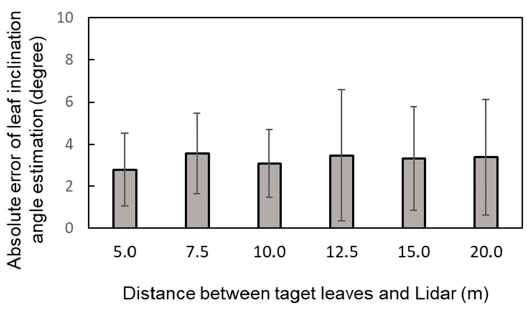
Figure 4. Relationship between distance to target leaves from lidar and absolute error of leaf angle inclination angle estimation.